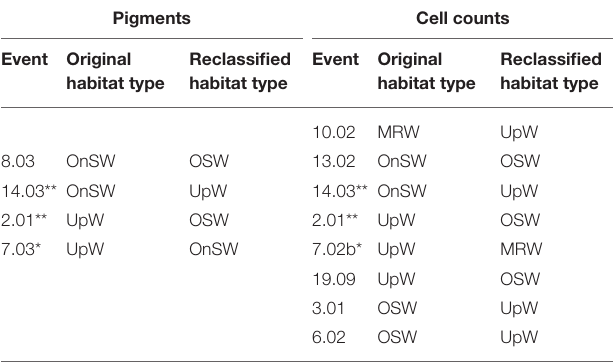
TABLE 4 | Events that were misclassified during the canonical analysis of principal coordinates (CAP) cross-validation routine.